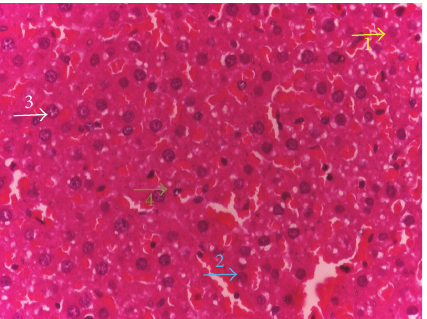
Figure 1: Representative microscopic tissue images of rat liver were given 50mg/kg/day NaNO 2 (H&E). The histopathology scores of observation are 1 (yellow arrow), 2 (blue arrow), and 3 (white arrow) showing no changes, indicating mild/moderate and severe changes, respectively.Photographswereobtainedbylightmicroscopyat400 × magnification.